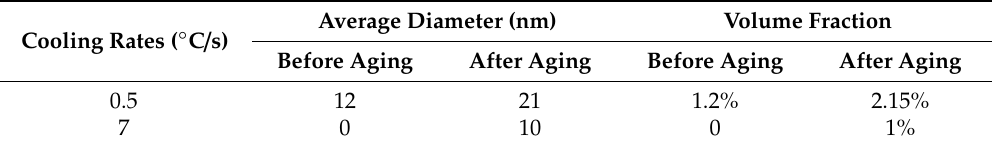
Figure 10. Copper precipitates in the specimens cooled at ( a ) 0.5 ◦ C / s, ( b ) 0.5 ◦ C / s after aging, and ( c ) 7 ◦ C / s after aging at 400 ◦ C for 2 h. Table 3. Size and volume fraction of the copper precipitates in the specimens cooled at 0.5 ◦ C / s and 7 ◦ C / s before and after